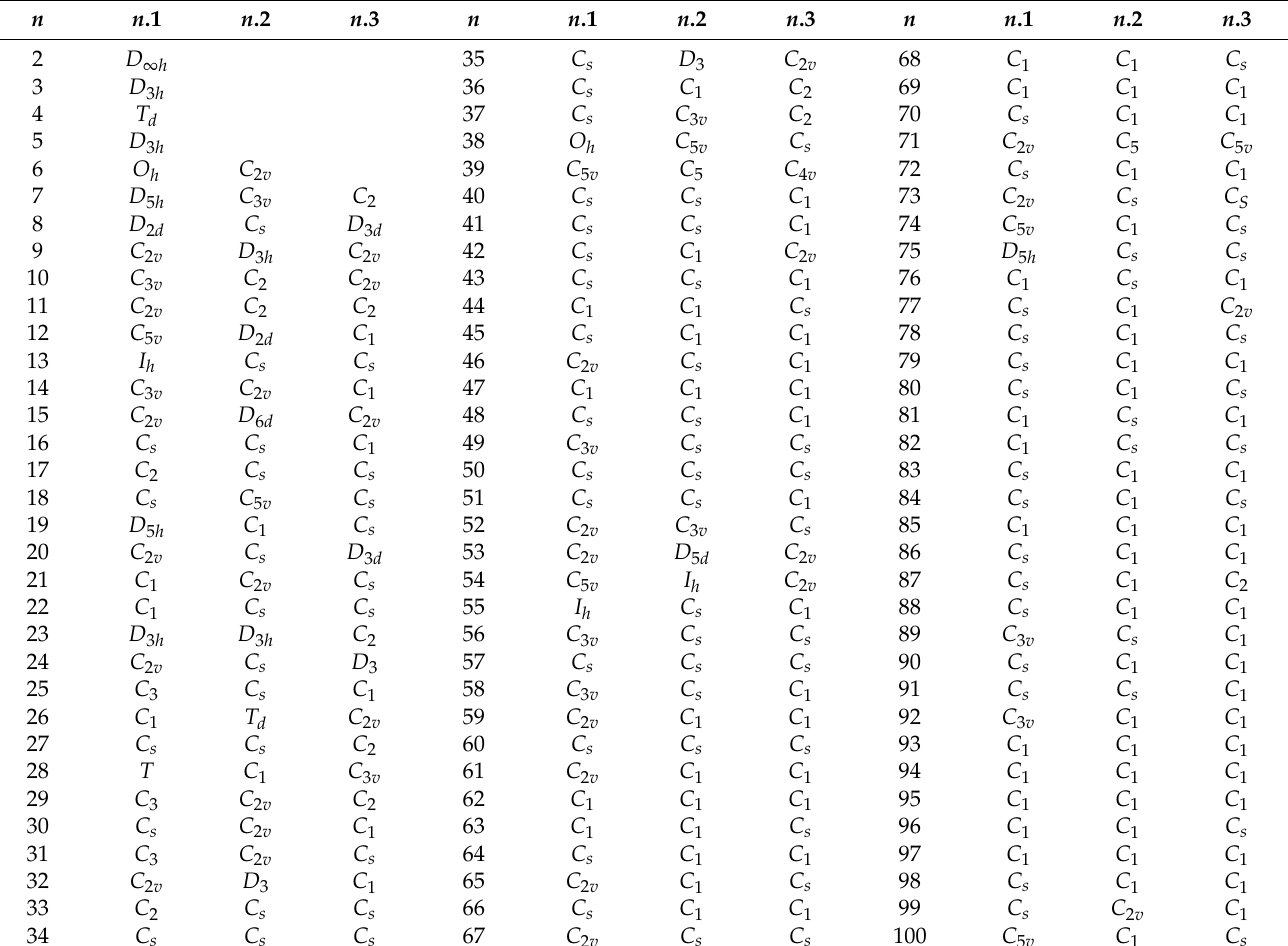
Table 2. Point groups of the optimized Ag n clusters from the EAM calculations. n .1, n .2, and n .3 represents the results for the energetically lowest, 2nd lowest, and 3rd lowest isomer,